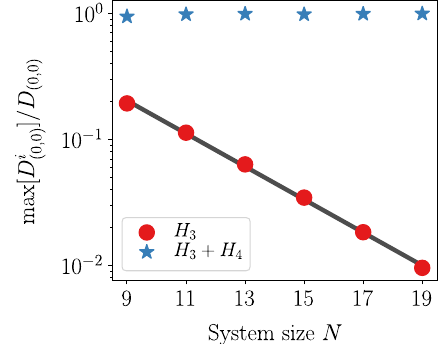
FIG. 9. Diagnosing strong and weak fragmentation. Ratio be- tween the dimension of the largest invariant subspace H i within the (0, 0) symmetry sector and the total dimension of the (0 ,0) sector D . For H 3 (red dots), this ratio vanishes exponentially fast with ð 0 ; 0 Þ the system size, while it approaches one for H 3 þ H 4 (blue